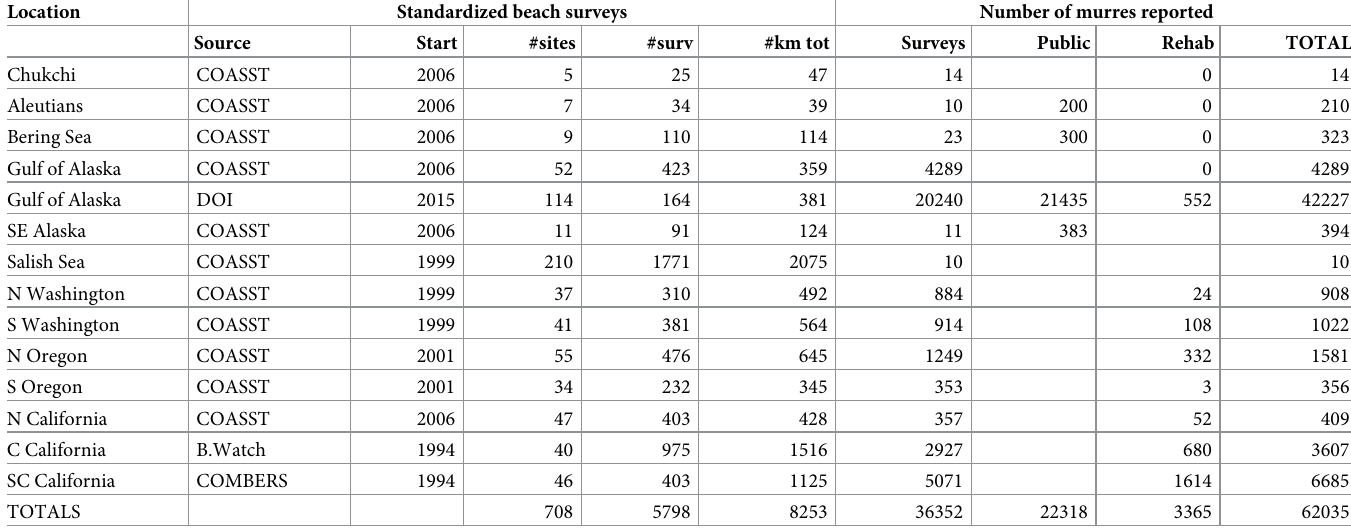
Table 1. Standardized beached bird survey effort, number of murres reported on surveys, and murres reported by members of the public or delivered to rehabilita- tion centers between May 2015 and Apr 2016. Sources: COASST- Coastal Observation and Seabird Survey Team, DOI- Department of the Interior agencies, B.Watch- Beach Watch, COMBERS-